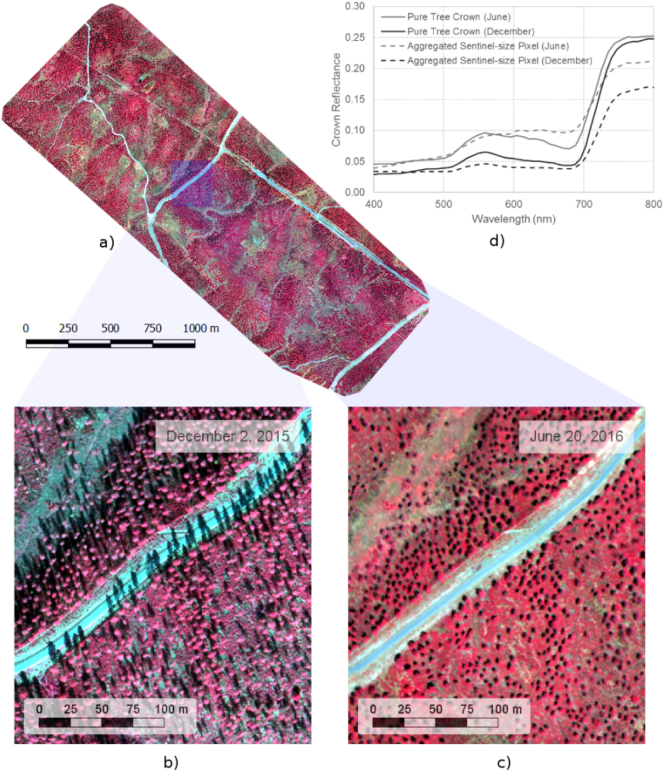
Airborne hyperspectral image acquired with the VNIR hyperspectral sensor at 40 cm resolution over the entire area of study (a) showing the large shadow effects due to sun-angle changes between December (b) and June (c) acquisition dates. The hyperspectral reflectance of a pure tree crown, and the corresponding Sentinel-2A aggregated pixel, show larger shadow effects in the aggregated pixel than in the pure tree reflectance as a function of the acquisition date (d).